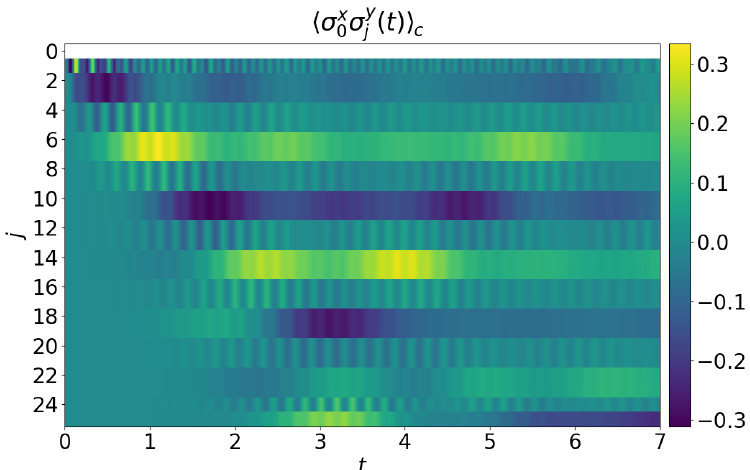
Figure 9: A space-time diagram of the X Y connected correlation function of qubit 0 with all of the other 25 qubits in the same simulation as in Fig. 8. Notable correlations develop between the Pauli- X operator of the driven qubit and Pauli Y of the qubits whose lab frequency is resonant with it, located at alternating positions along the two plaquette arms. These correlations build up following the propagation of the front of the information signal from the driven qubit, as can be seen by comparison with Fig. 8. The ensuing full two-point correlation matrix in the long-time limit is shown in Fig. 11.